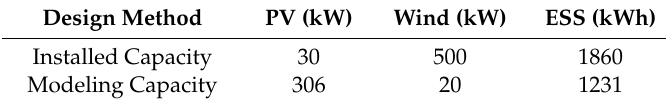
Table 8. Installed capacity and modeled one by estimated load pattern for Island